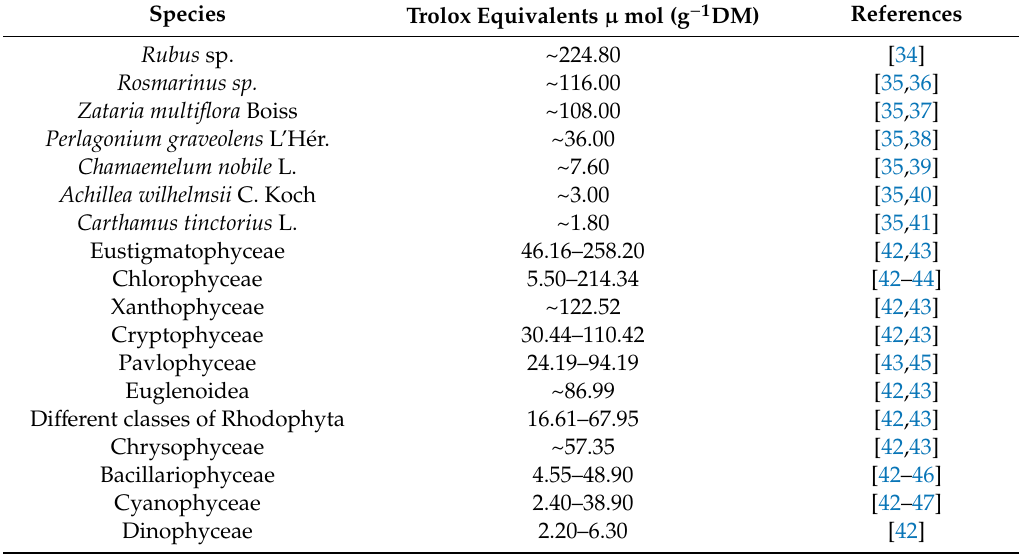
Table 2. Antioxidant activity (Trolox equivalents, µ mol (g − 1 DM)) of di ff erent higher plants and microalgal